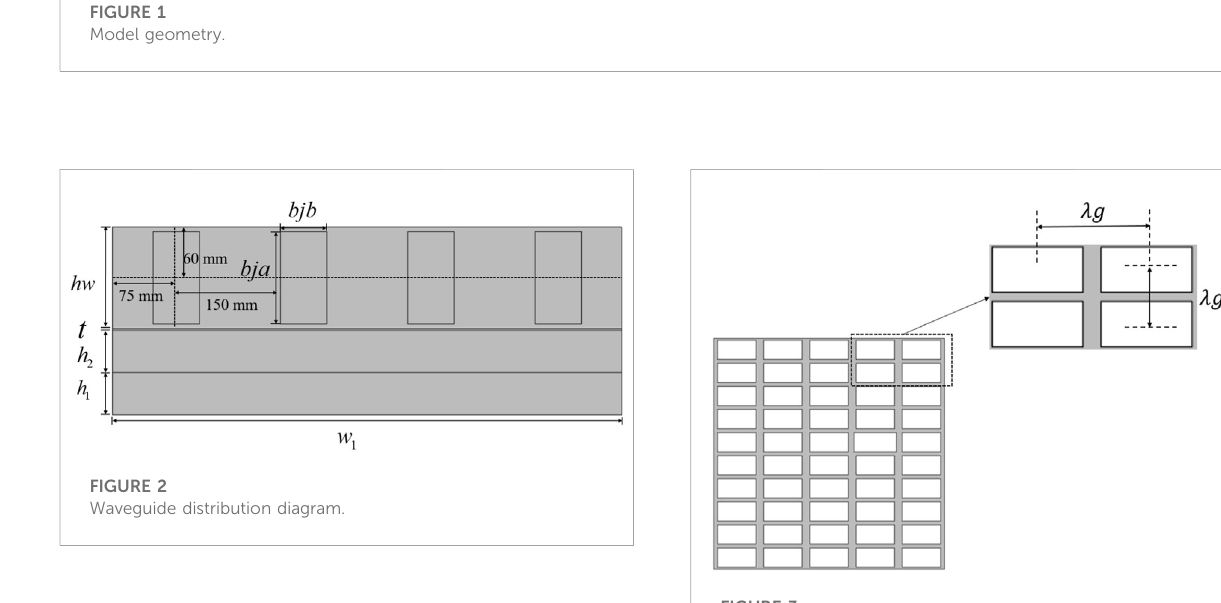
FIGURE 3 Schematic of a uniform slot